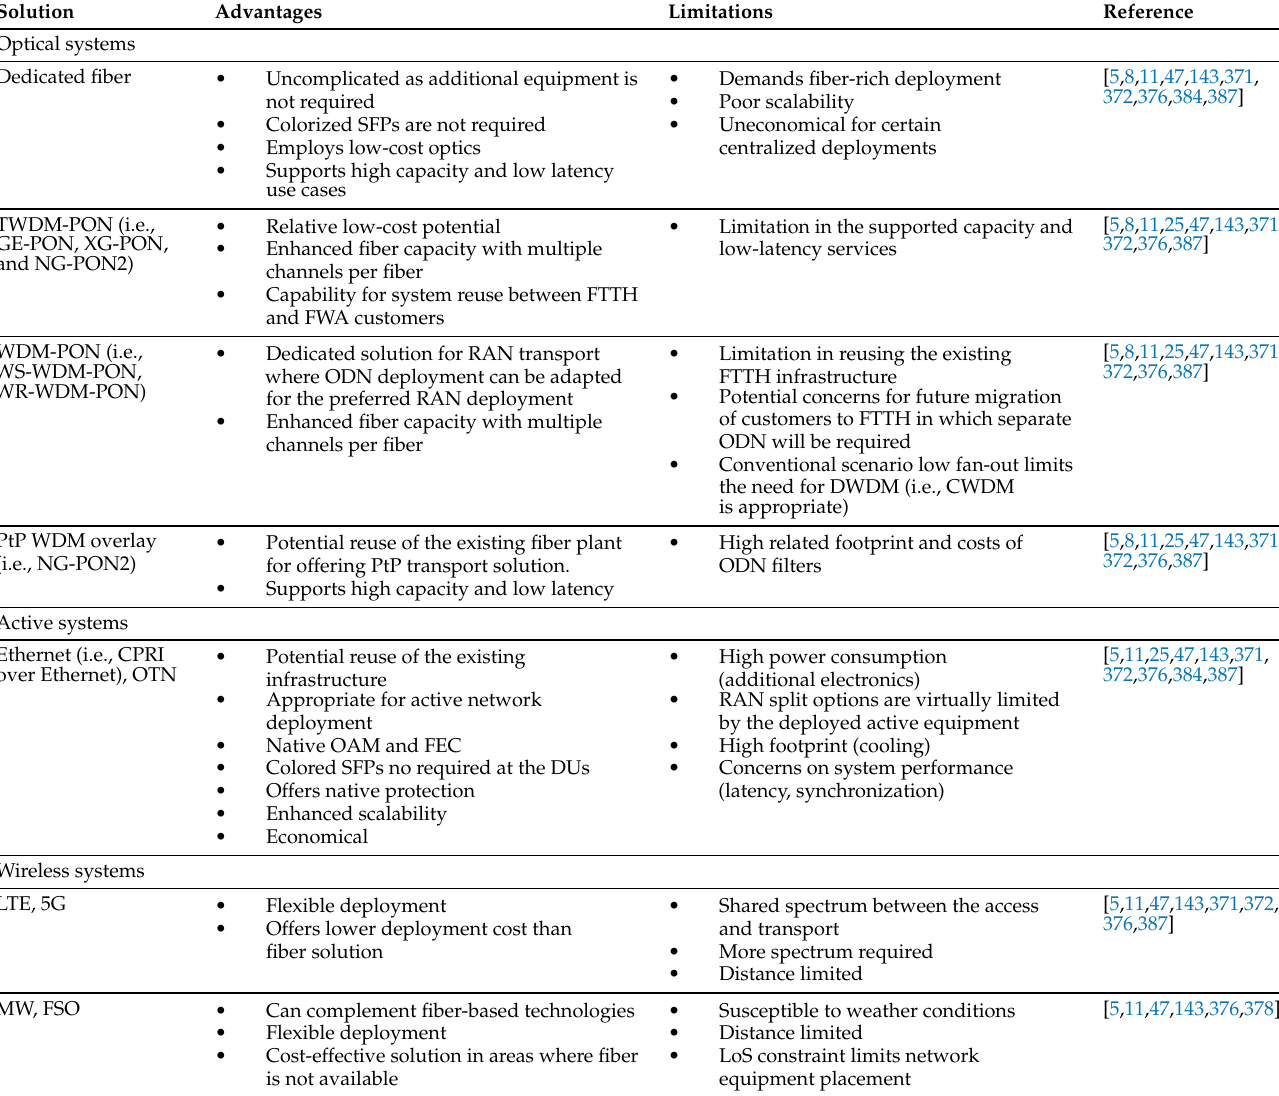
Table 12. Comparison of potential transport network solutions for